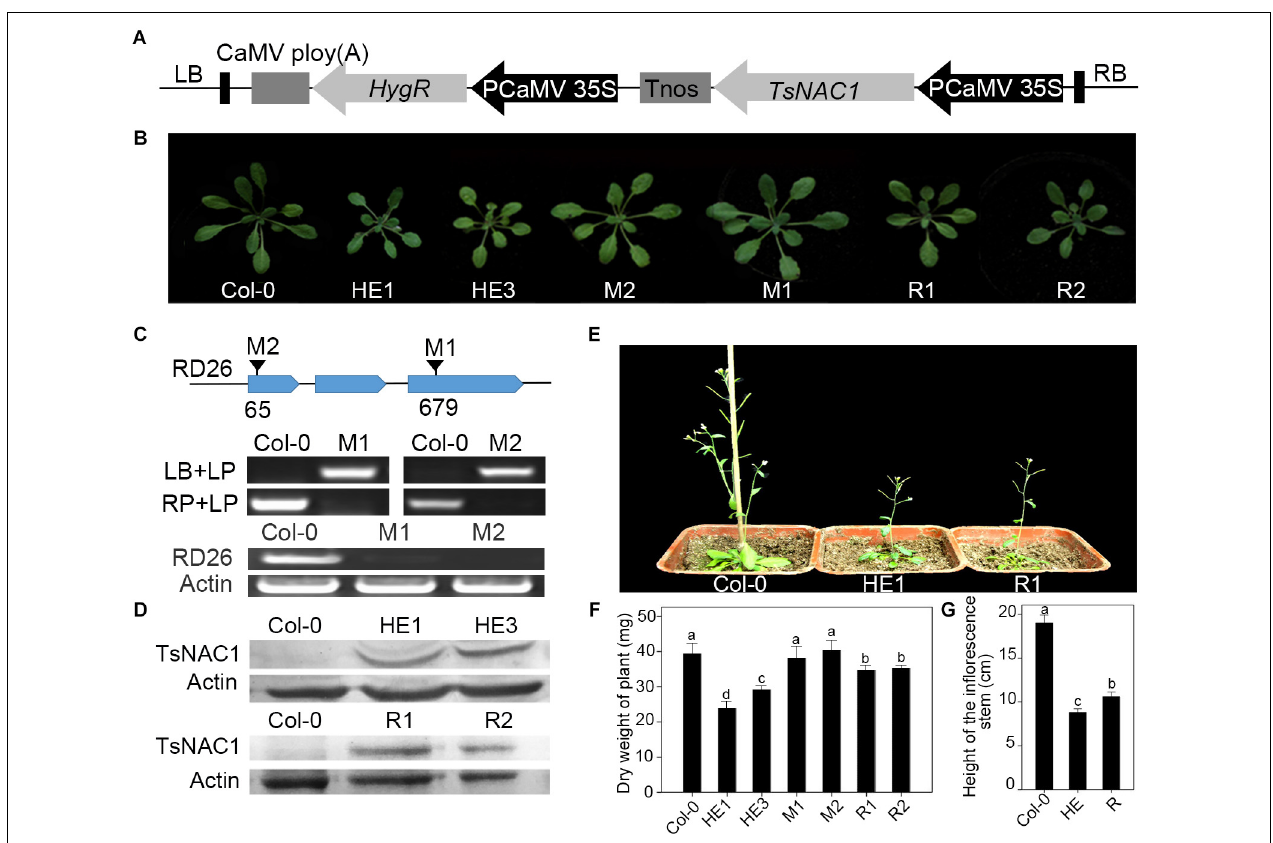
FIGURE 1 | Heterologous expression of EsNAC1 retarded the growth of Arabidopsis . (A) The diagram for the T-DNA region of EsNAC1 expression vector. (B) Rosettes of representative EsNAC1 transgenic plants and mutants of RD26 4 weeks after planting. (C) The identification of homozygous T-DNA insert mutants. LP, LB and RP were primers provided on the T-DNA Primer Design page. The results of RT-PCR indicated the expression loss of RD26 in M1 and M2. (D) The western blot results of HE lines and Revertants (overexpressed EsNAC1 in the T-DNA insertion mutants of RD26). (E) Phenotypes of EsNAC1 transgenic plants after sowing 6 weeks in the medium of peat:vermiculite (2:1). (F) The dry weight of the whole plants. (G) The height of the inflorescence stems at 6 weeks. HE1, HE3: Different heterologous expression lines; M1, M2: Different T-DNA insert mutant lines; R1, R2: Different revertants. Values represent the mean ± SD, and those labeled with a letter are significantly different at P < 0.05 by Duncan’s test. Three biological replicates were in the experiment, with each biological replicate consisting of 20